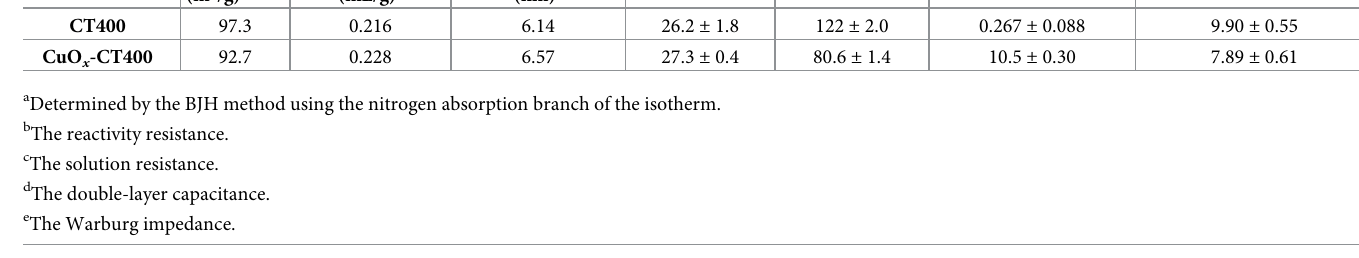
Table 1. Model parameters of all the photocatalysts based on EIS and BET. Samples BET (m 2